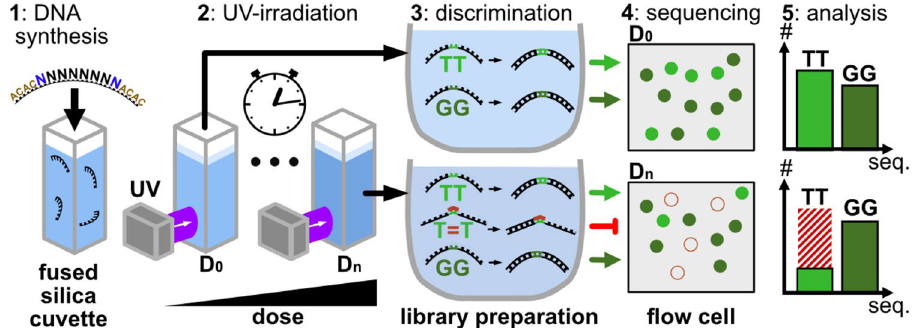
Figure 1. Experiment. Step 1: Short synthetic DNA strands with a central random hexamer (black) flanked by a tag sequence (brown) and spacer random nucleotide (blue) are synthesized to form a naïve sequence library. Step 2: The DNA strands in a cuvette irradiated with UV laser light at 266 nm to induce photolesions. Step 3: The irradiated sample is split into a number of samples with defined irradiation doses. Subsequent library preparation for high throughput sequencing selects and amplifies only intact sequences without UV lesions for next generation sequencing (Step 4). Step 5: Analysis of the data, normalization and correction yields the abundance of sub-mers up to hexamer length for subsequent analysis of the sequence dependent damage